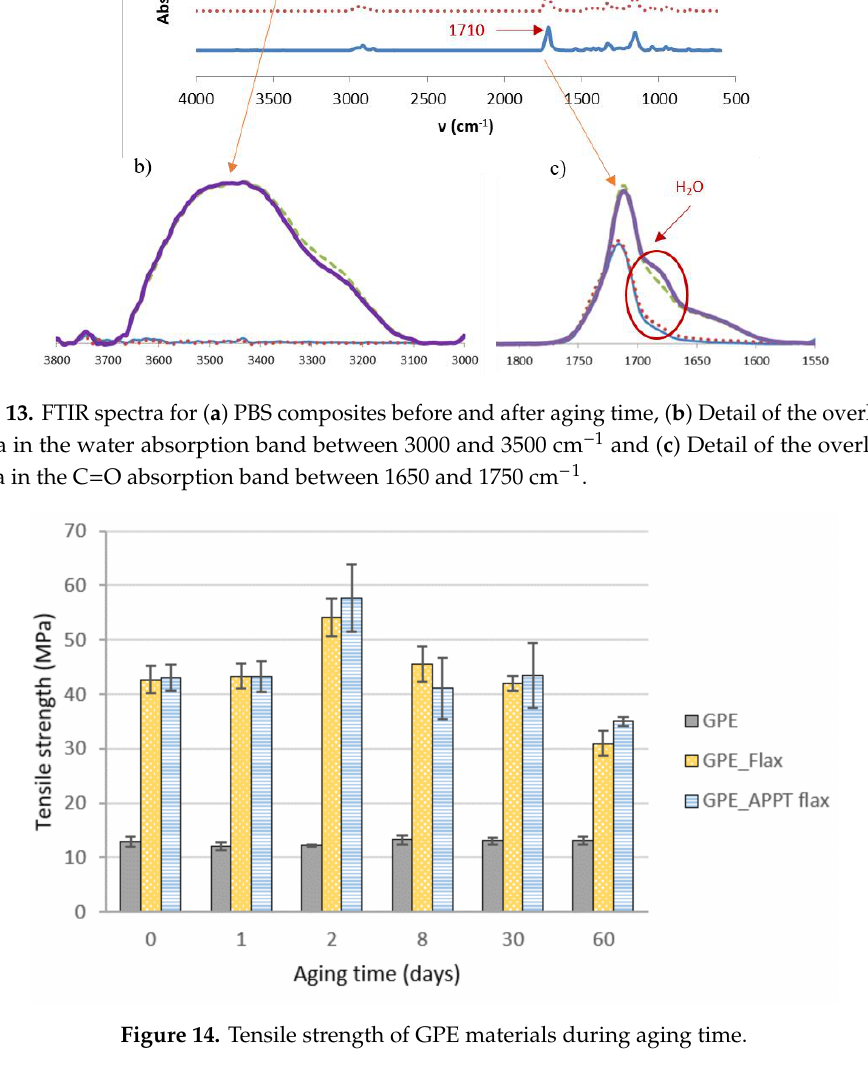
Figure 14. Tensile strength of GPE materials during aging